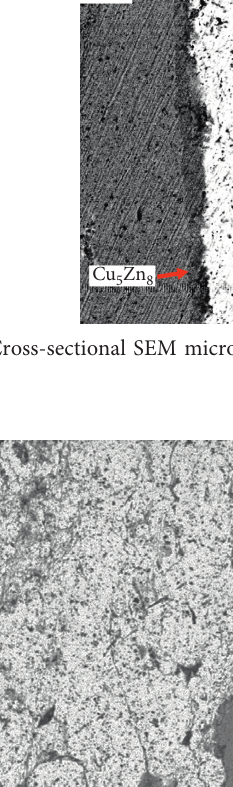
8 Zn 3 Bi 1 Mg active solder.